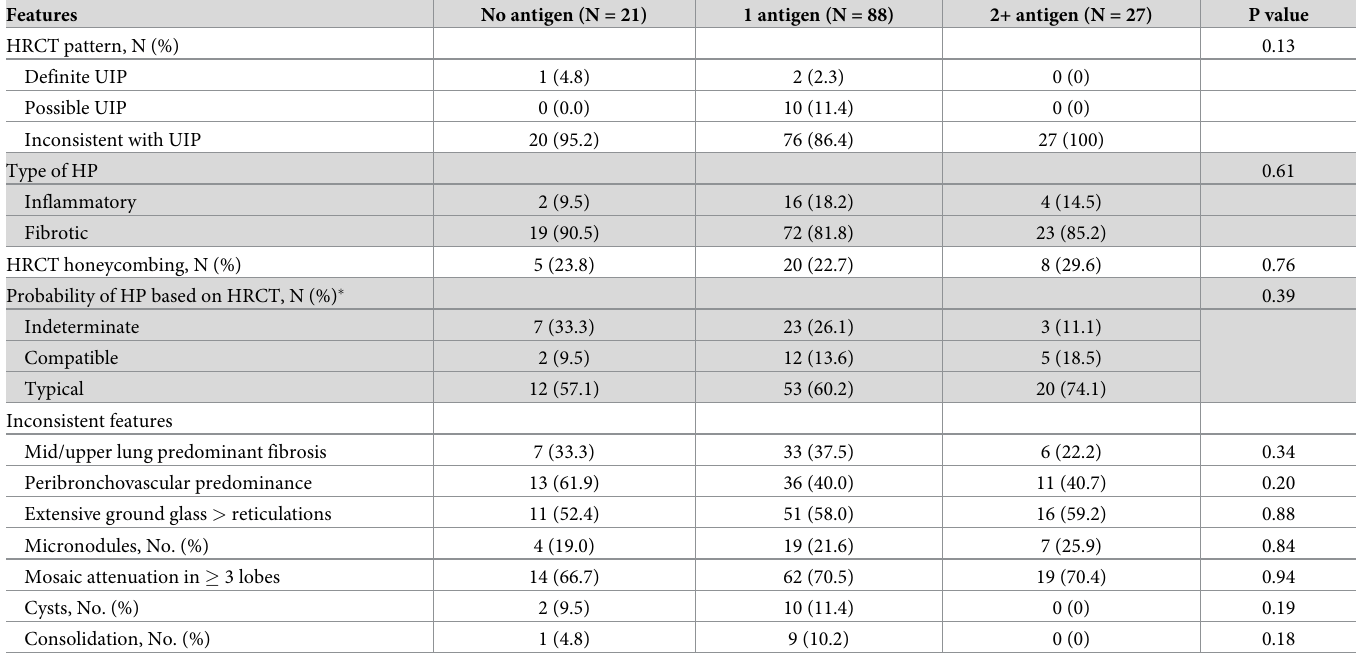
Table 3. Radiographic and histopathologic features of retrospective